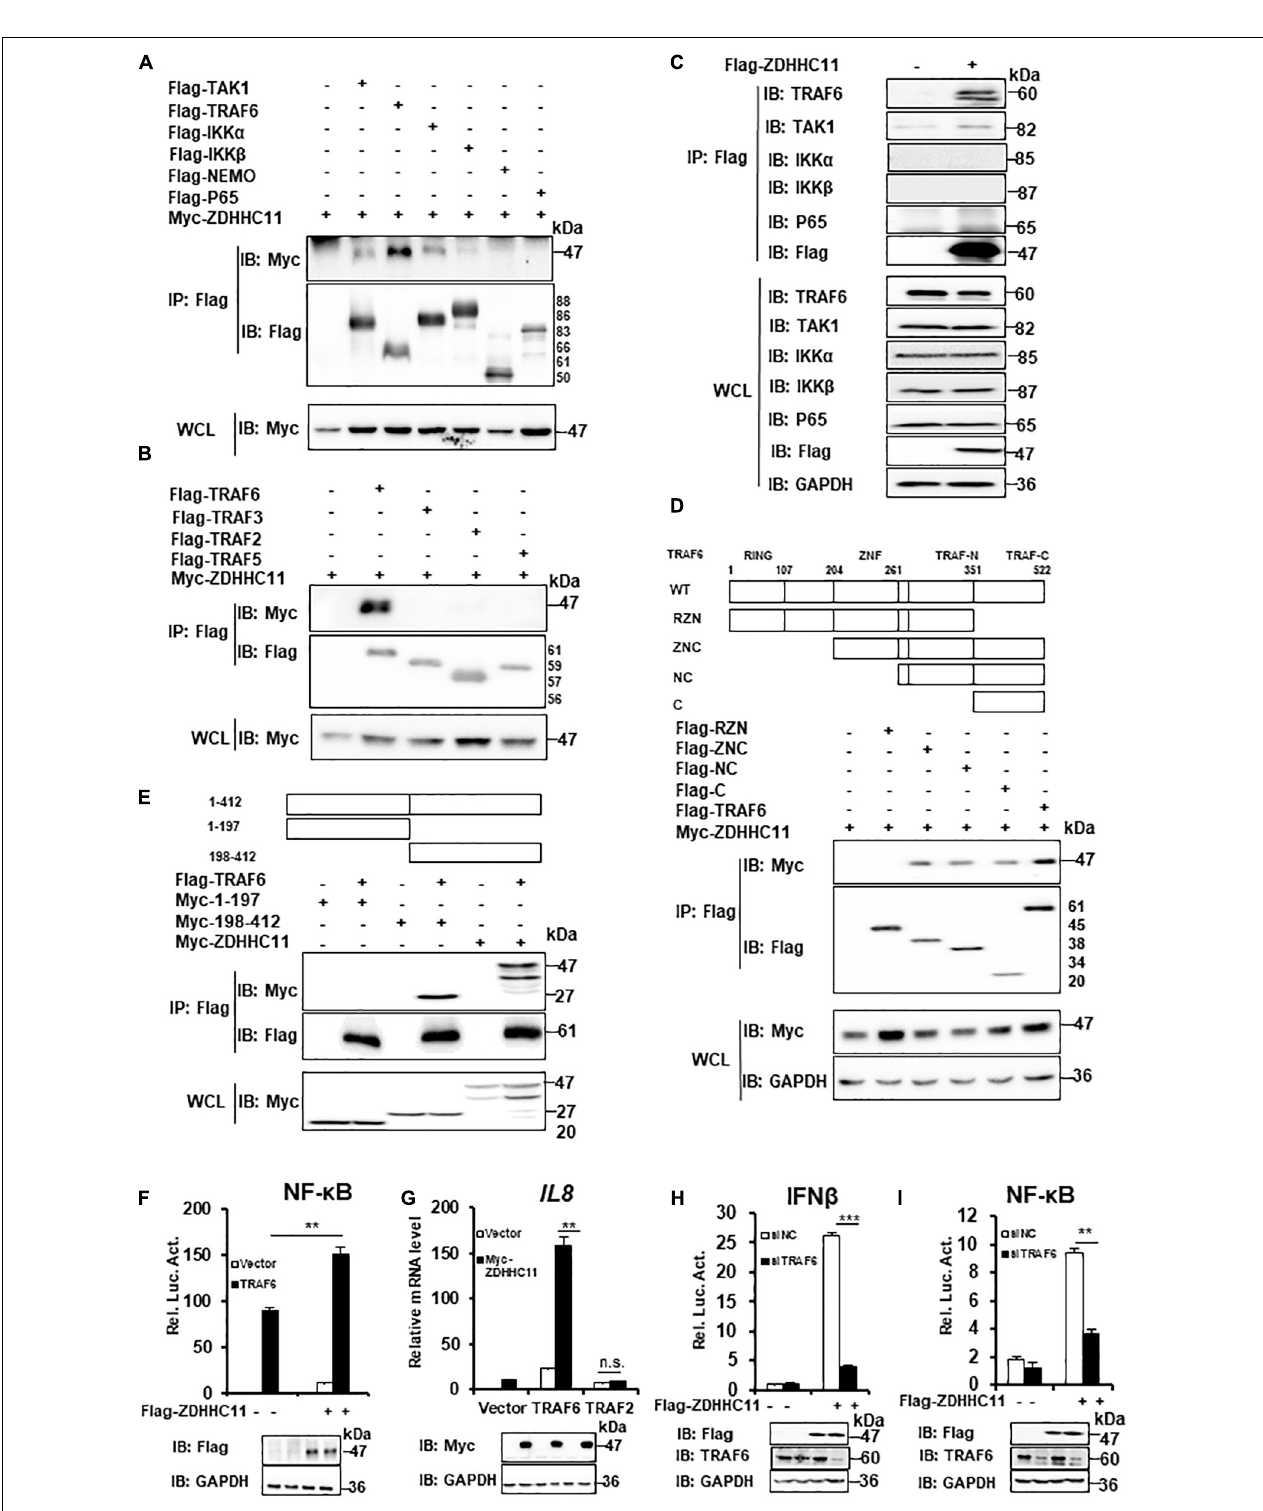
FIGURE 4 | ZDHHC11 targets TRAF6 to modulate NF- κ B signaling. (A,B) HEK293T cells were transfected with the indicated expression plasmids, After 24 h of transfection, co-immunoprecipitation were performed with anti-Flag beads and then followed by immunoblot assay with the corresponding antibodies. (C) HEK293T cells were transfected with an empty vector or Flag-tagged ZDHHC11 (3 µ g) expression plasmid. 24 h later, co-immunoprecipitation were performed with anti-Flag beads, followed by immunoblot assay with the corresponding antibodies. (D) HEK293T cells were cotransfected with ZDHHC11 (2 µ g) and TRAF6 (2 µ g) or its